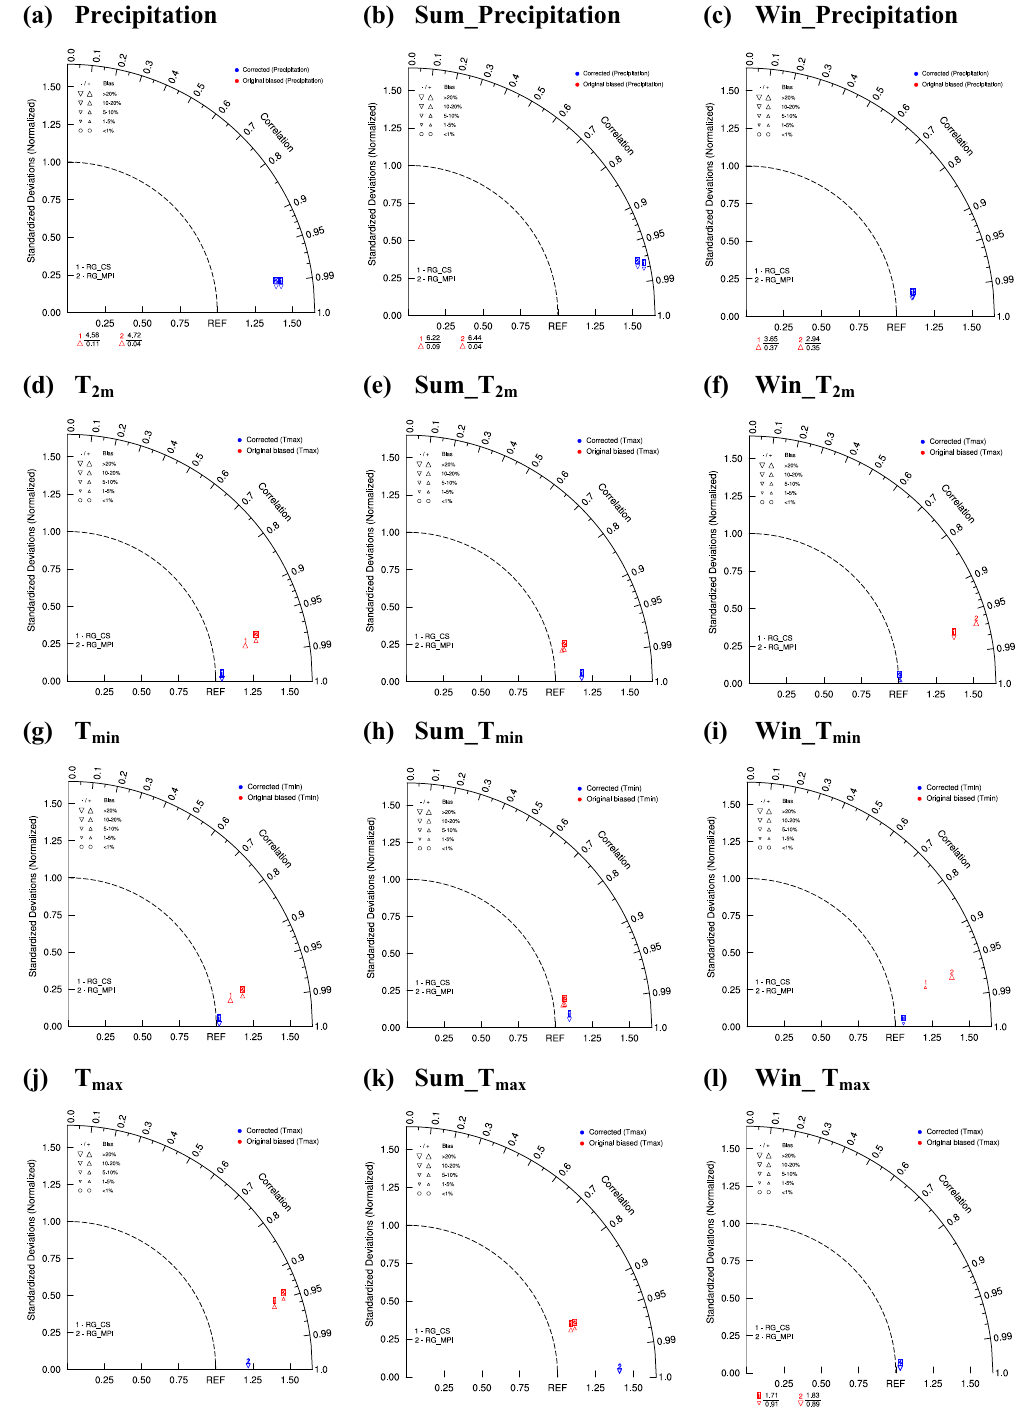
Figure 6. Taylor diagrams of precipitation (a–c) , T 2m (d–f) , T min (g–i) and T max (j–l) before and after the revision from R_CS and R_MPI for the reference period. (annual, left panels; summer, middle panels; winter, right panels). The figure was prepared using The NCAR Command Language version 6.5.0. (https:// doi. org/ 10. 5065/ D6WD3